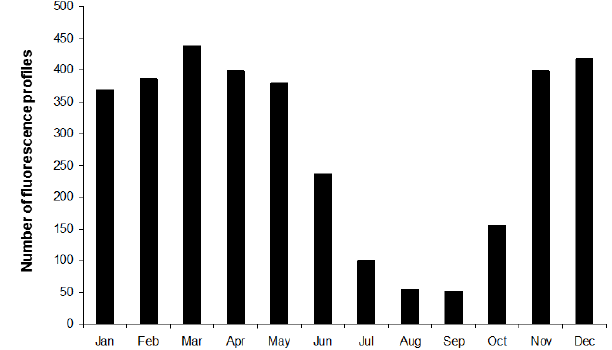
Figure 5. Monthly distribution of the fluorescence